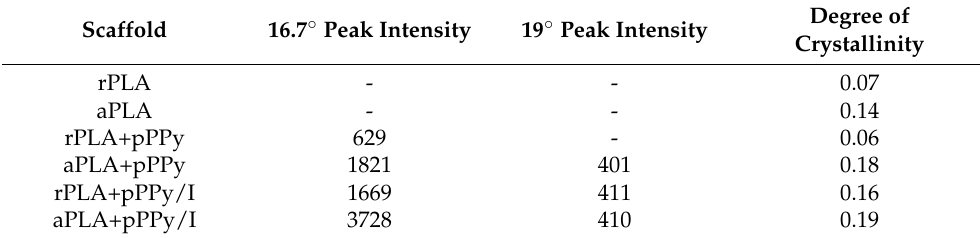
Table 1. Characteristic peak intensity and degree of crystallinity of fabricated scaffolds. Scaffold 16.7 ◦ Peak